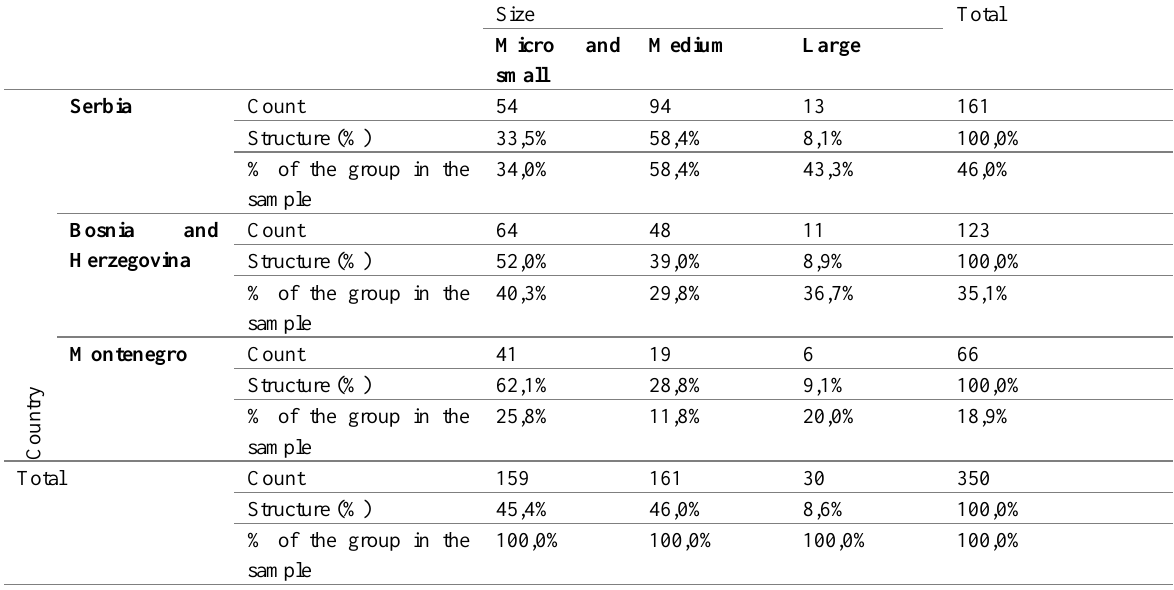
Table 2: Size of